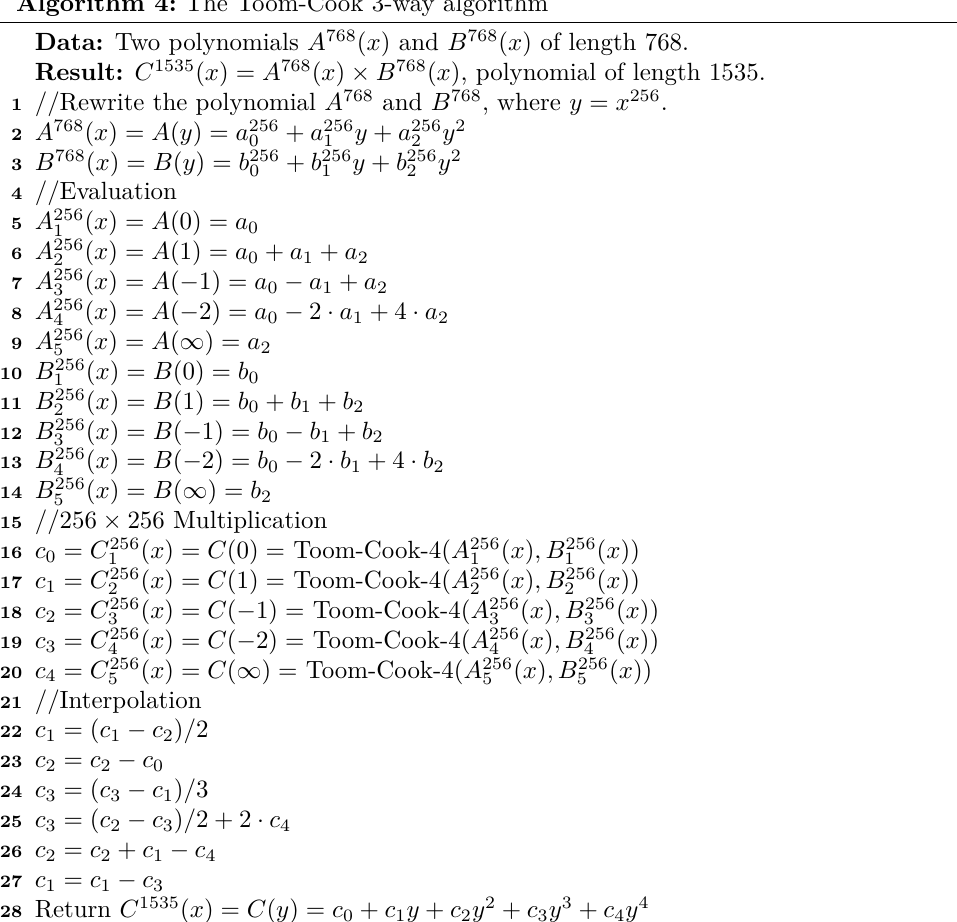
Algorithm 4: The Toom-Cook 3-way